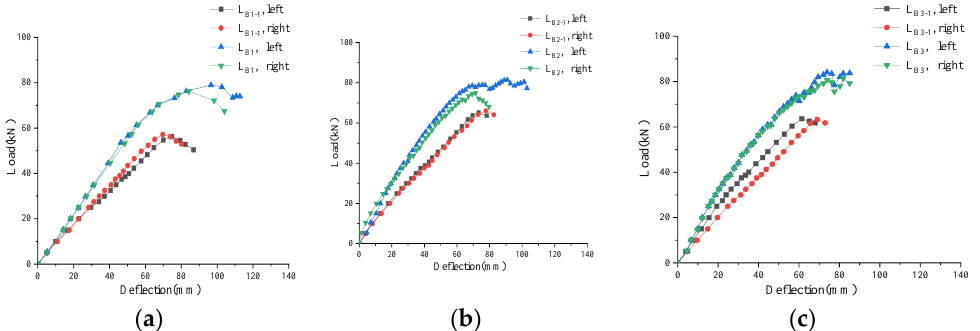
Figure 20. Load – displacement curve of group B. ( a ) 0 kN, 4 steel wires; ( b ) 7 kN, 4 steel wires; ( c ) 14 Figure 20. Load-displacement curve of group B (long-term beam). ( a ) 0 kN, 4 steel wires; ( b ) 7 kN, kN, 4 steel wires. 4 steel wires; ( c ) 14 kN, 4 steel wires.